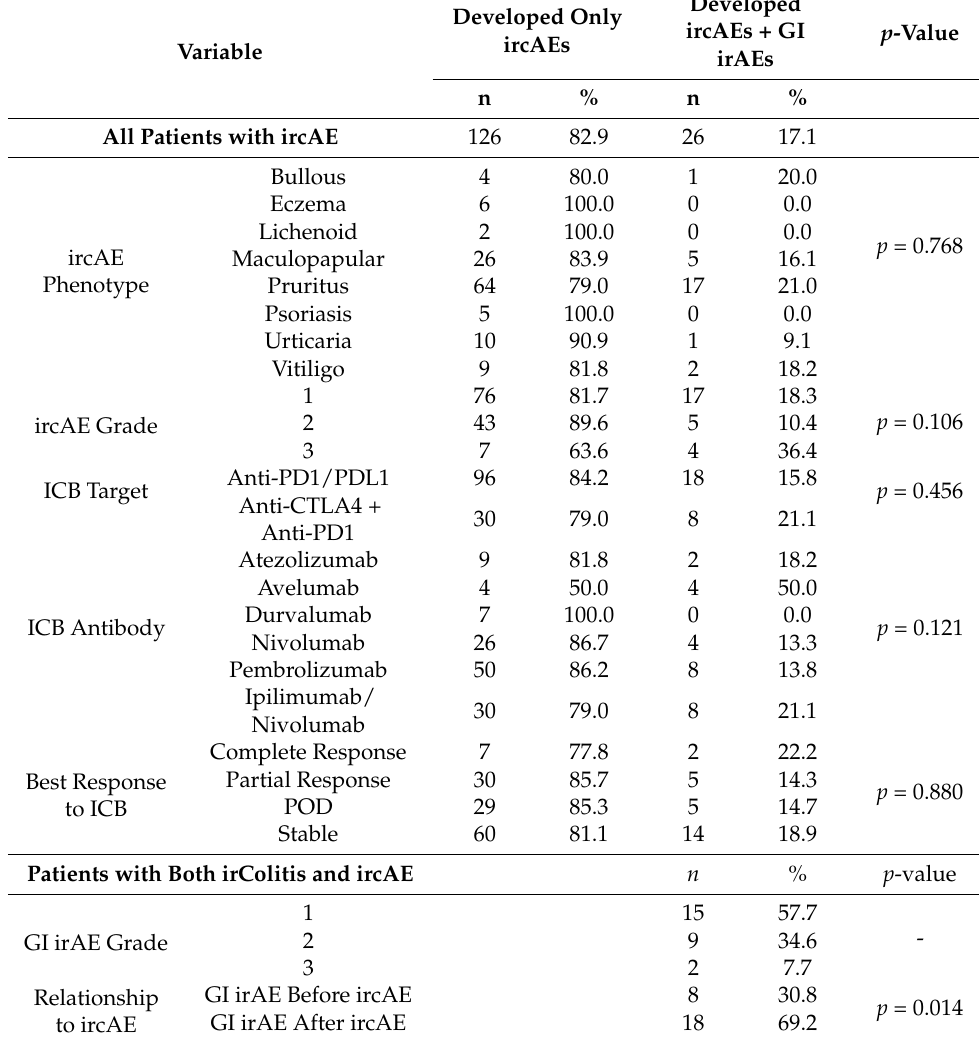
Table 2. Cohort 1: GI irAE characteristics in patients with